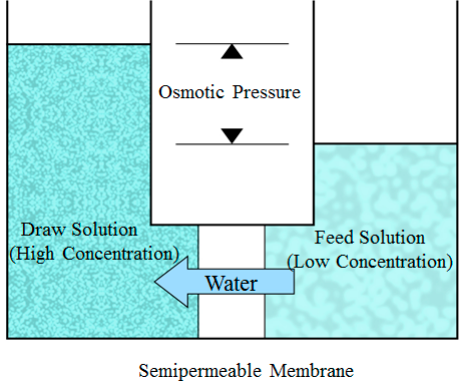
Figure 1. Schematic Diagram of Forward Osmosis Process.